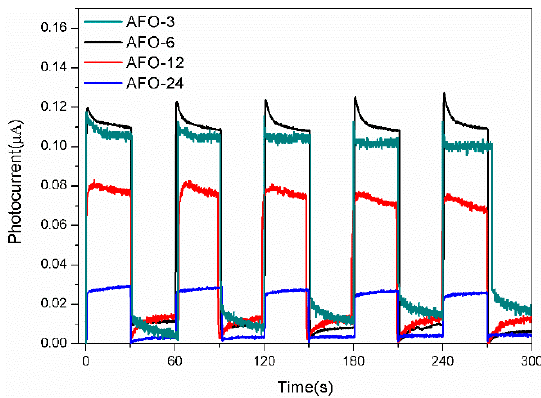
Figure 6. Photocurrent response of as ‐ prepared AgFeO 2 samples with different reaction time.